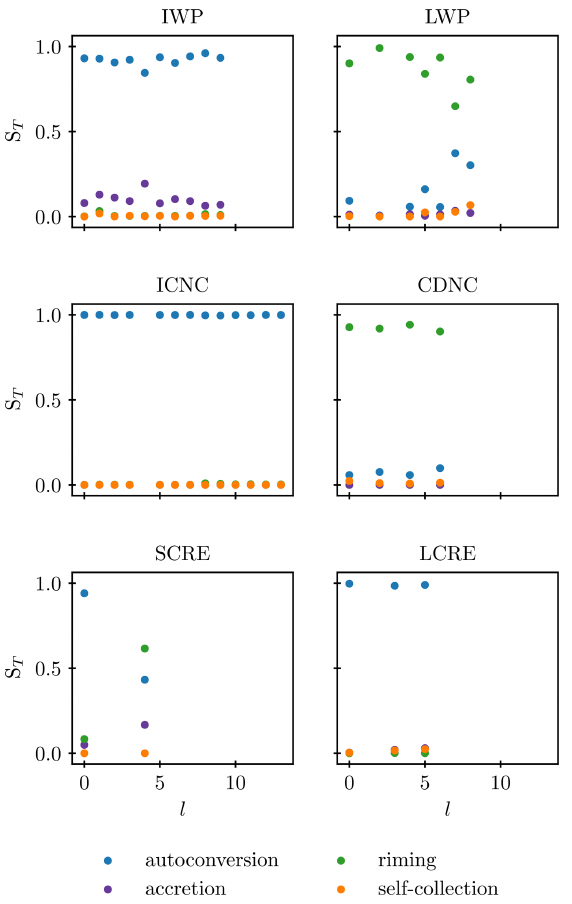
Figure C1. Same as Fig. 11 but for the total sensitivity indices.